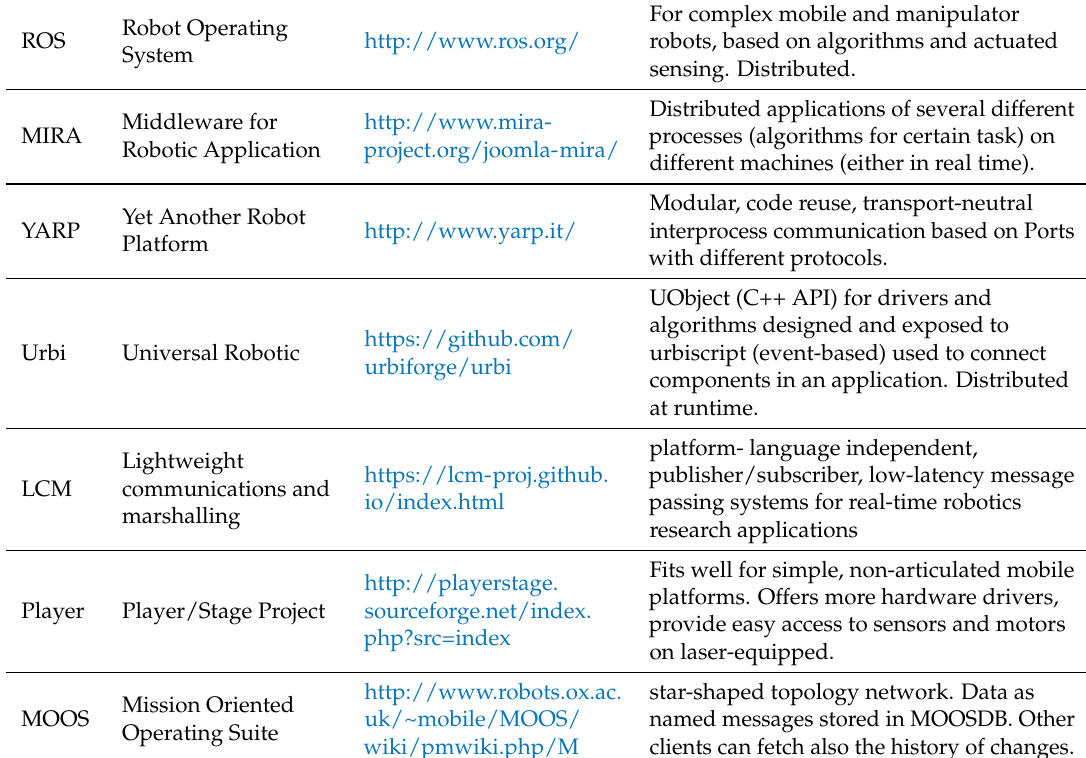
Table 1. Middleware platforms